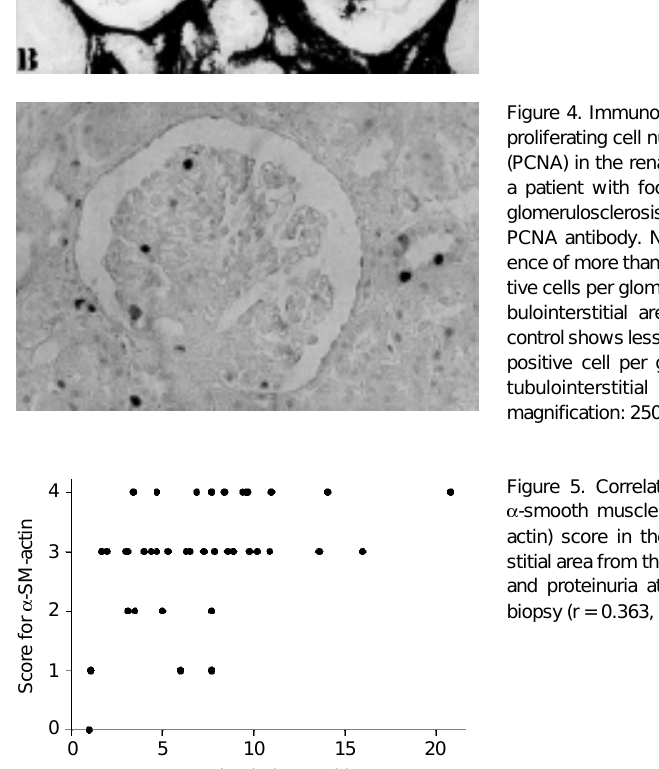
Figure 4. Immunolocalization of proliferating cell nuclear antigen (PCNA) in the renal cortex from a patient with focal segmental glomerulosclerosis using an anti- PCNA antibody. Note the pres- ence of more than 2 PCNA-posi- tive cells per glomerulus and tu- bulointerstitial area, while the control shows less than 1 PCNA- positive cell per glomerulus or tubulointerstitial area (original magnification: 250X).